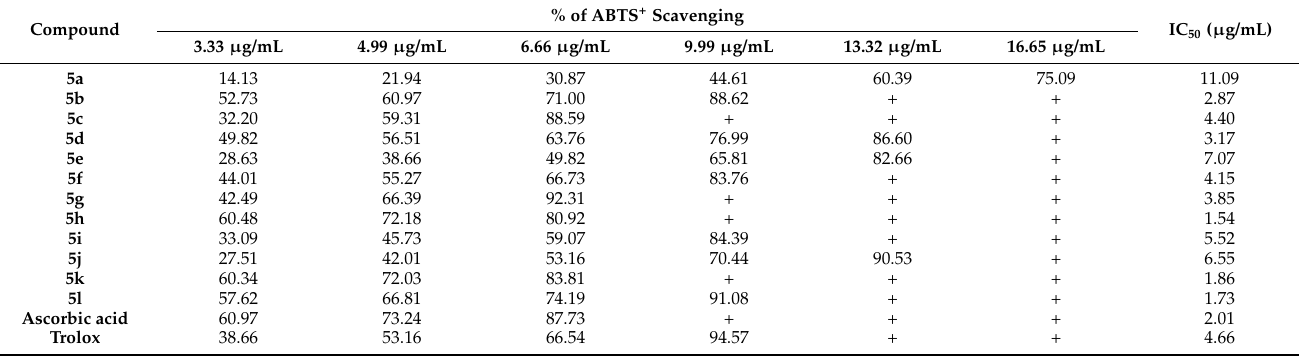
Table 1. Results of the ABTS + scavenging assay.